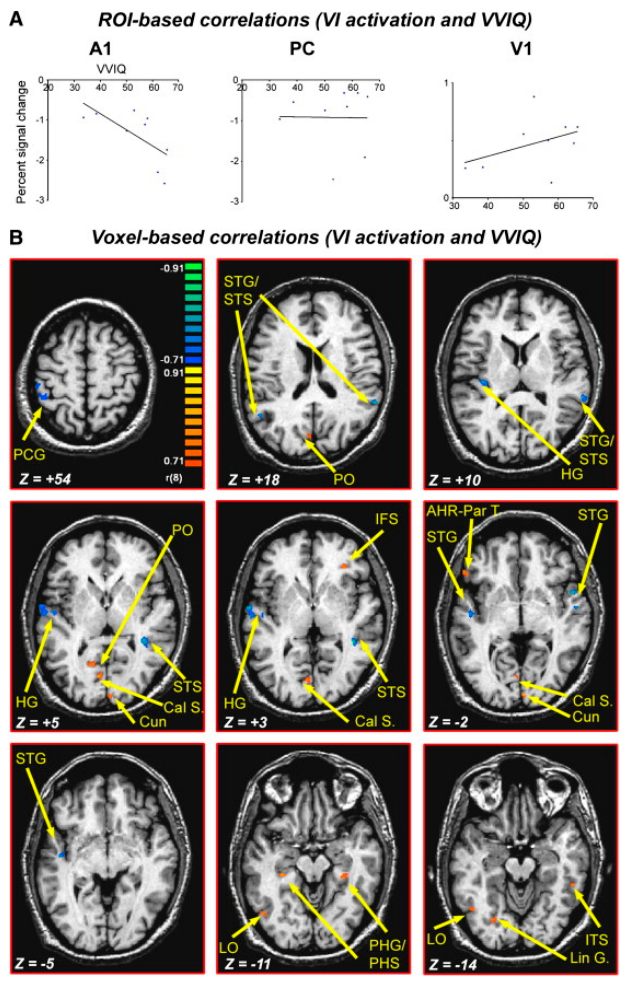
Figure 6. Correlation between VVIQ scores and VI BOLD signal. ( A ) Correlations between the percent signal change for VI in each subject and the VVIQ scores of these individual subjects in three ROIs. There were significant negative correlations between A1 (primary auditory cortex) activity and the vividness of the imagery, a trend for positive correlations with V1 (primary visual cortex) and no correlation with PC (posterior cingulate ‘default brain’ area). ( B ) Voxel-by-voxel correlations between VI activity and individual VVIQ correlations. Results presented on axial slices covering mainly auditory cortex. The investigators found negative correlations in auditory and somatosensory cortex only. Positive correlations were found in visual, prefrontal and parahippocampal areas bilaterally. Reprinted with permission from ref. [59]. 2005. A. Amedi et al. Perceptual images of objects require the retinal blind spot and occluded objects to be filled in and completed. Age-related eye diseases such as microdegeneration, myopia and refractive errors, cataract, diabetic retinopathy and glaucoma, amblyopia and strabismus